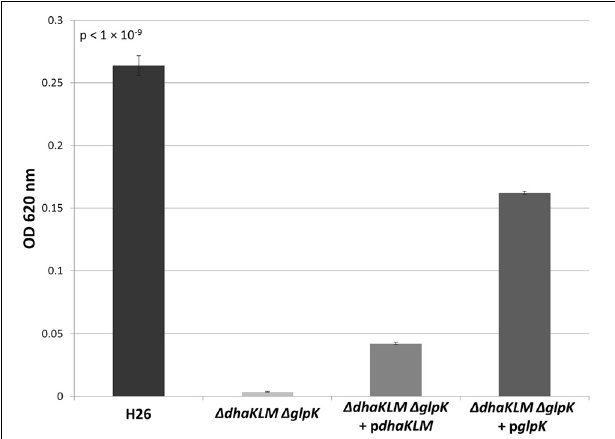
FIGURE 5 | Cell density of H26, (cid:2) dhaKLM (cid:2) glpK , (cid:2) dhaKLM (cid:2) glpK + p dhaKLM , and (cid:2) dhaKLM (cid:2) glpK + p glpK at stationary phase when grown on 5mM DHA. Cell density is represented by the average optical density (OD 620 ) reading of three cell culture replicates. Error bars depict the standard deviation of the averages. ANOVA single factor, p < 1 × 10 − 9